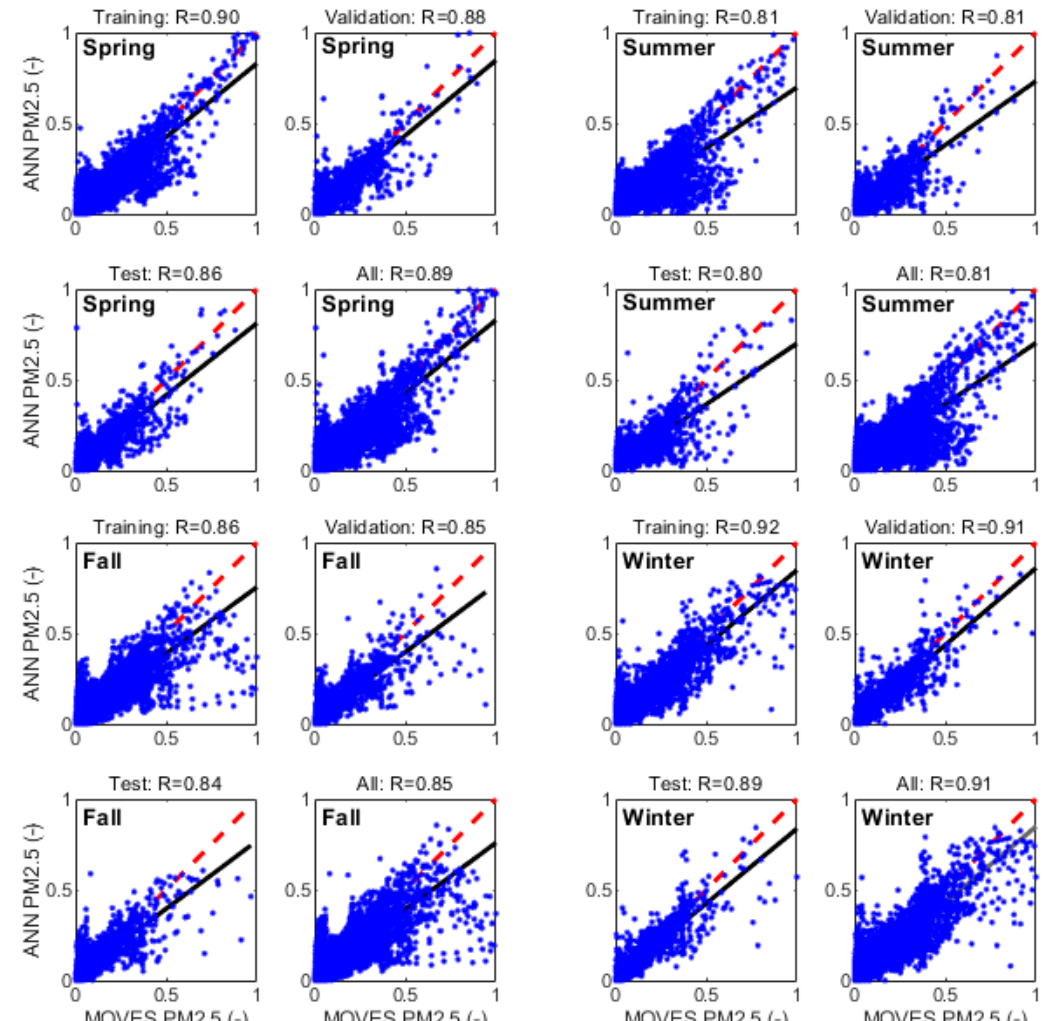
Figure 6. Seasonal performance of the ANN model, four subplots upper left: spring; four subplots upper right: summer; four subplots bottom left: fall; four subplots bottom right: winter. The seasons are generated from the years 2010, 2014, and 2018. The plots represent the training (70%), validation (15%), and test (15%) datasets as well as all three together (100%).